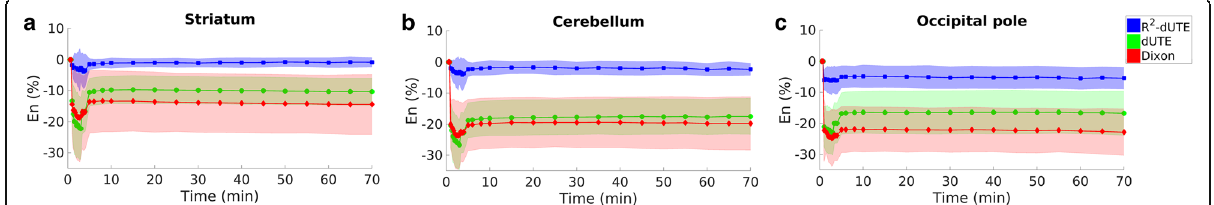
Fig. 3 En and standard deviation among subjects obtained with the μ -map dUTE − R2 (blue), μ -map dUTE (green), and μ -map DXN (red), measured in the striatum ( a ), cerebellar cortex ( b ), and occipital pole ( c )